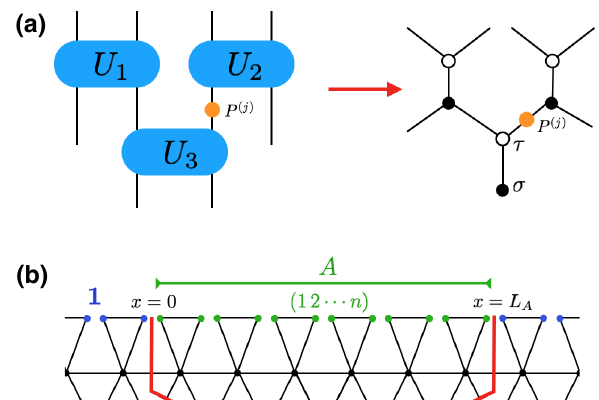
FIG. 10. (a) Performing a Haar average over each two-site uni- tary gate in the hybrid dynamics in the calculation of the von Neumann entanglement of a subsystem A yields an emergent lat- tice magnet with S n “spins” residing at the sites of a honeycomb lattice. Integrating out the spins on one sublattice yields the lat- tice model described in the text. (b) The Haar average in Eq. (41) yields the ratio of two partition functions that differ only in their boundary conditions, by the “insertion” of a domain wall at the boundaries of the A subsystem for the spins in the lattice magnet located at the final time slice. The domain wall is labeled by the cyclic element of the permutation group ( 1 2 . . . n )